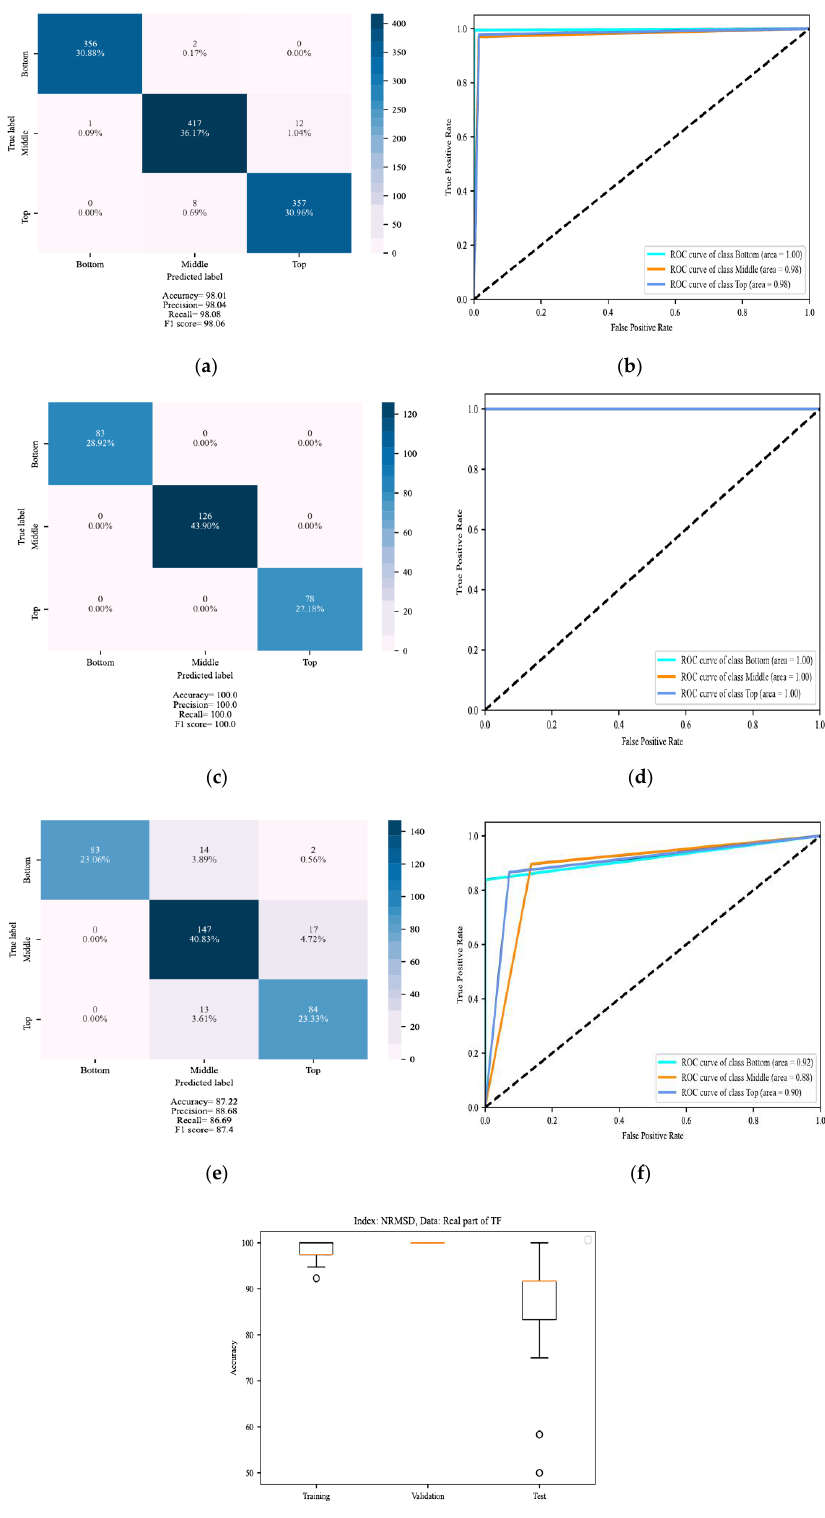
Figure 21. MLP performance in localization of the DSV fault using the extracted features from the real part of the TF using NRMSD index: ( a ) training confusion matrix; ( b ) training ROC curve; ( c ) validation confusion matrix; ( d ) validation ROC curve; ( e ) test confusion matrix; ( f ) test ROC curve; ( g ) box plot of the training, validation, and test accuracies in thirty iterations.